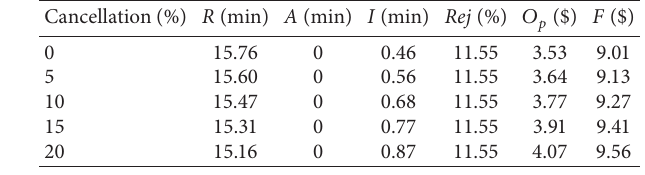
Table 2: Simulation results under different DOD values.